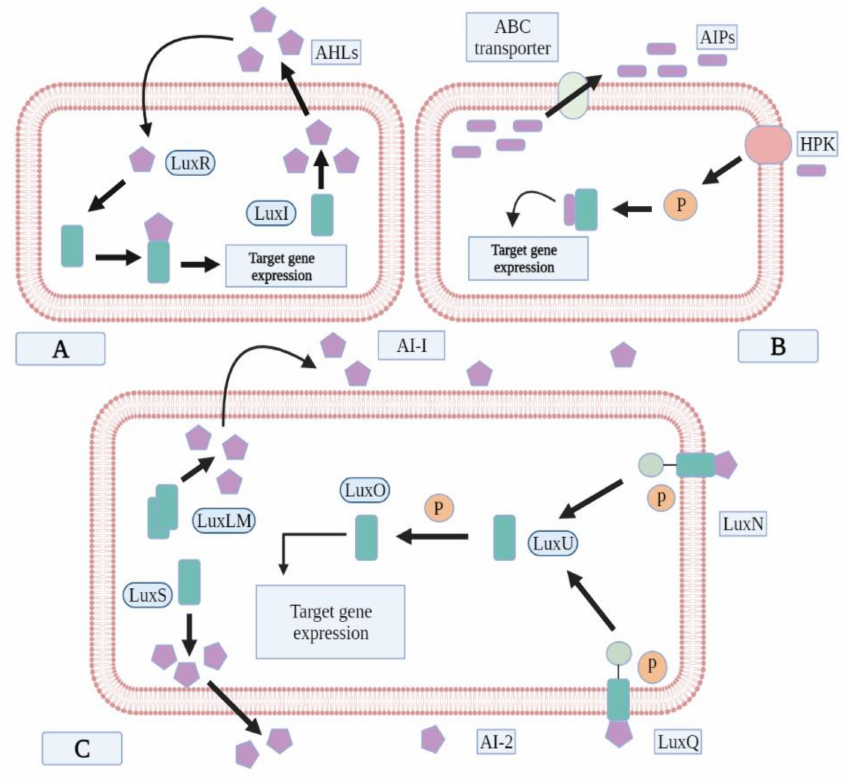
Figure 3. Typical QS signaling pathways. ( A ) AHL pathway seen in Gram-negative bacteria, ( B ) AIP pathway seen in Gram-positive bacteria, ( C ) AI-2 pathway seen in both Gram-negative and Gram- positive